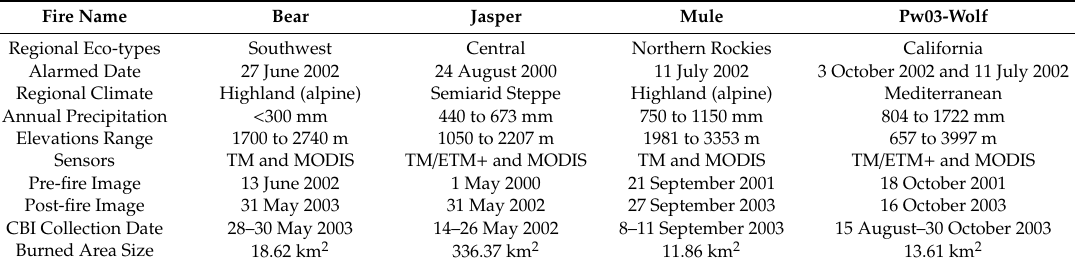
Table 1. Summary of study area and data.